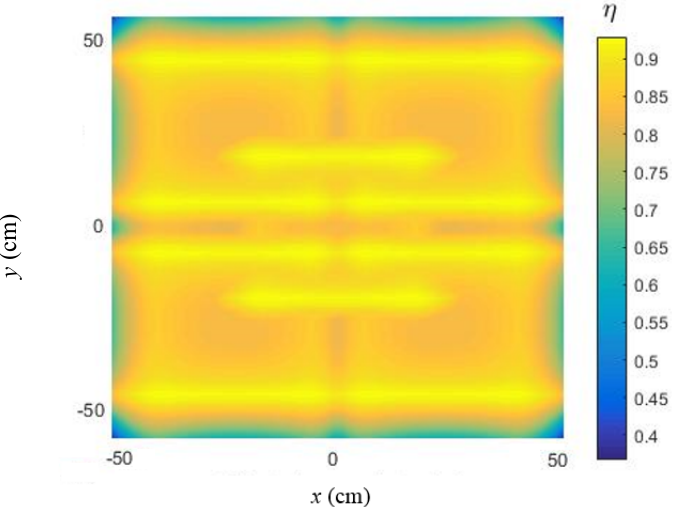
Figure 11. System efficiency map on the charging area/ground pad.